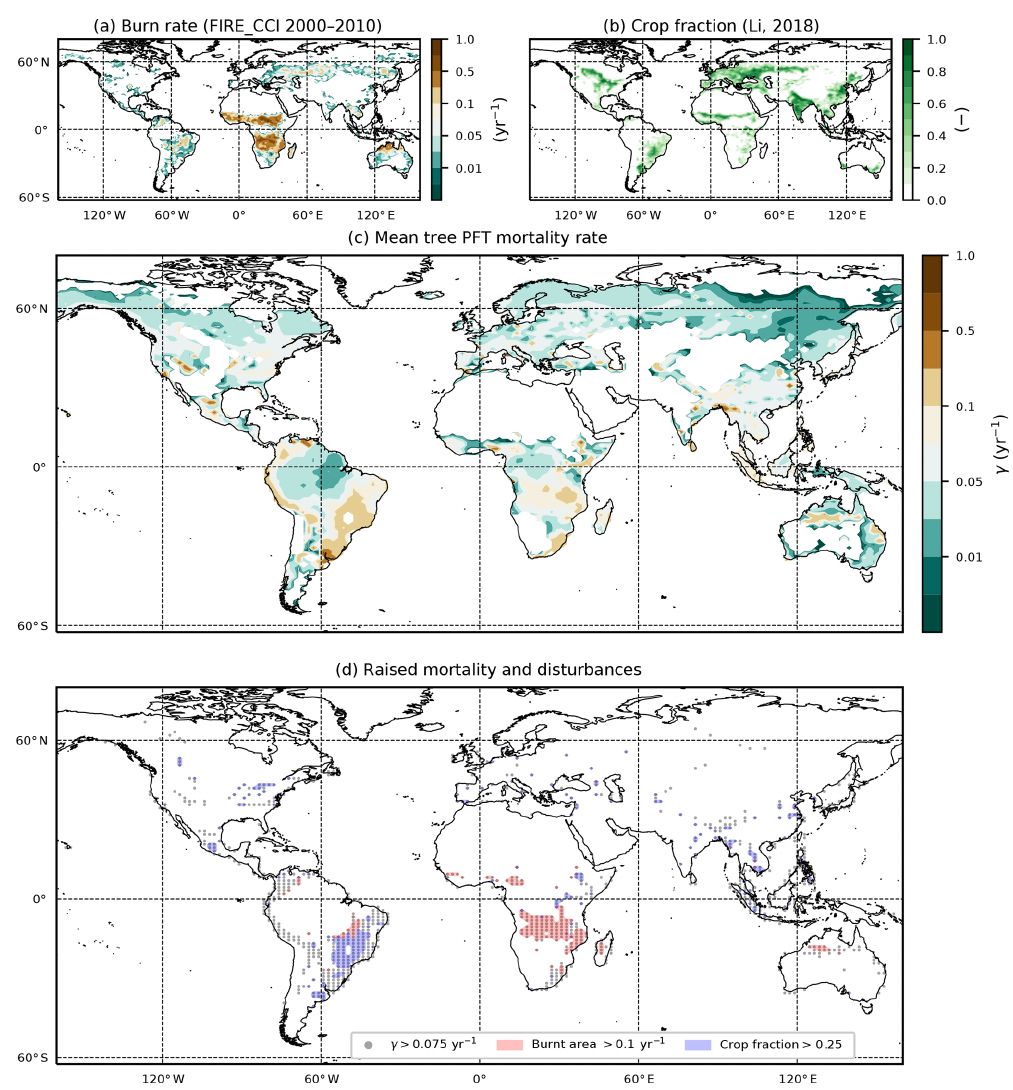
Figure 9. Comparison of diagnosed mortality rates, with observation-based maps of fire and land use. (a) Annual burnt area fraction from the ESA FIRE_CCI dataset; (b) crop fraction from the ESA LC_CCI 2000 dataset; (c) diagnosed mortality rate γ for the tree PFTs (BET-Tr, BET-Te, BDT, NET, NDT); (d) overlap of areas of higher tree mortality rates ( γ > 0 . 075yr − 1 ) with areas of fire (burnt area > 0 . yr − 1 ) and agriculture (crop fraction ≥